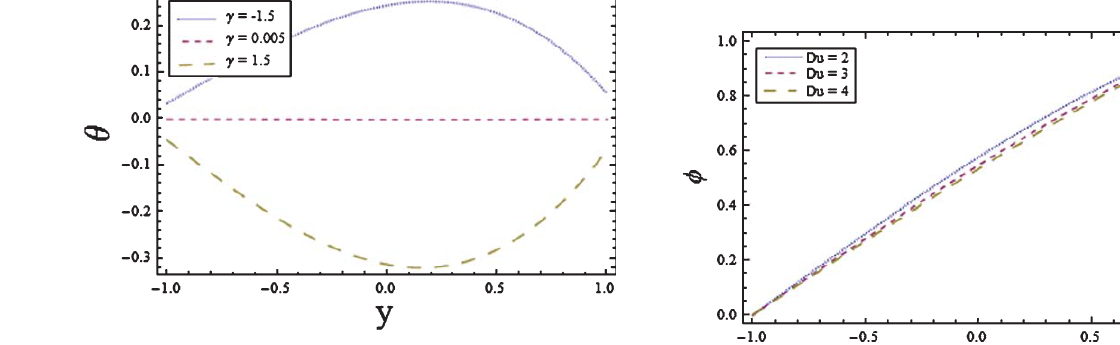
Fig. 10. Plot of the temperature θ for various values of the chemical reactionparameter γ with (cid:15) = 0 . 2, x = 0 . 1, t = 0 . 1 Sc = 1 , Sr = 2 , Du = 2 , γ = 10 , Pr = 1 . 5 and γ = 8 . 1 2